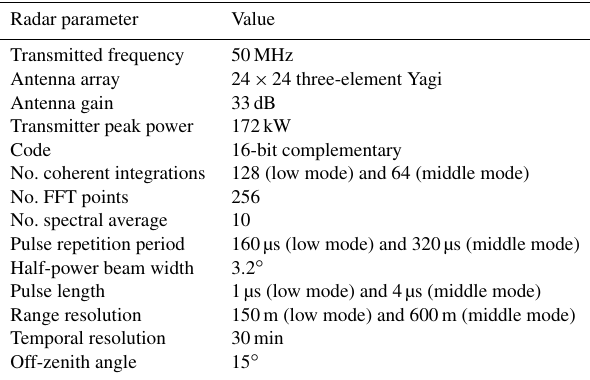
Figure 2. Example vertical profiles of (a) relative radar echo power (black line) along with its gradient variation (orange line), (b) radar aspect sensitivity (black line) along with its gradient variation (or- ange line), (c) radiosonde temperature, and (d) potential tempera- ture gradient at 00:00UTC on 4 November 2011. The horizontal red dashed line marks the LRT height. The orange circle in (a) de- notes the RT height. Table 1. Routine operational parameters in low and middle mode for the Beijing MST radar used in this